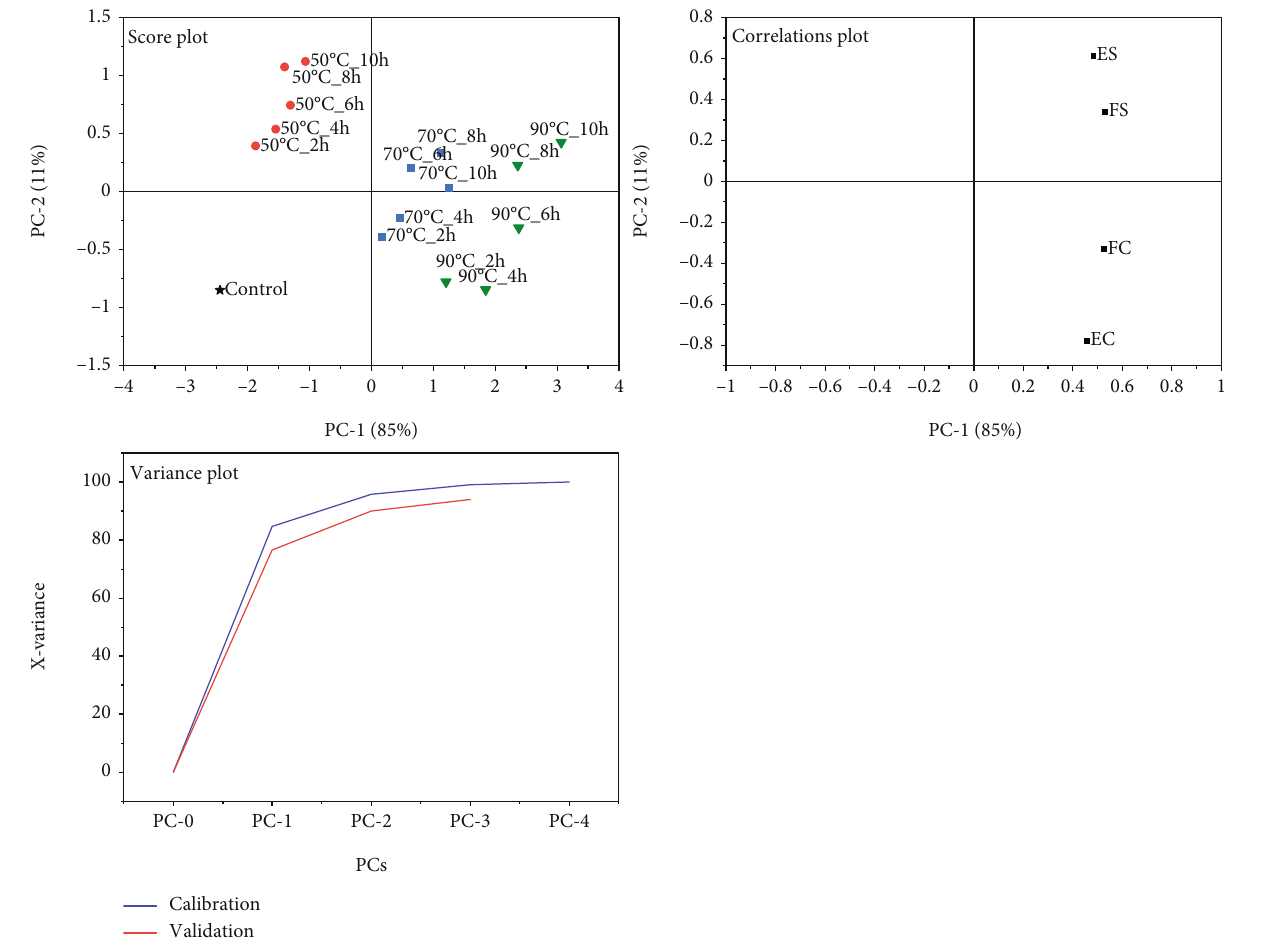
Figure 9: PCA plots of independent (scores) and dependent (loadings) variables for techno-functional